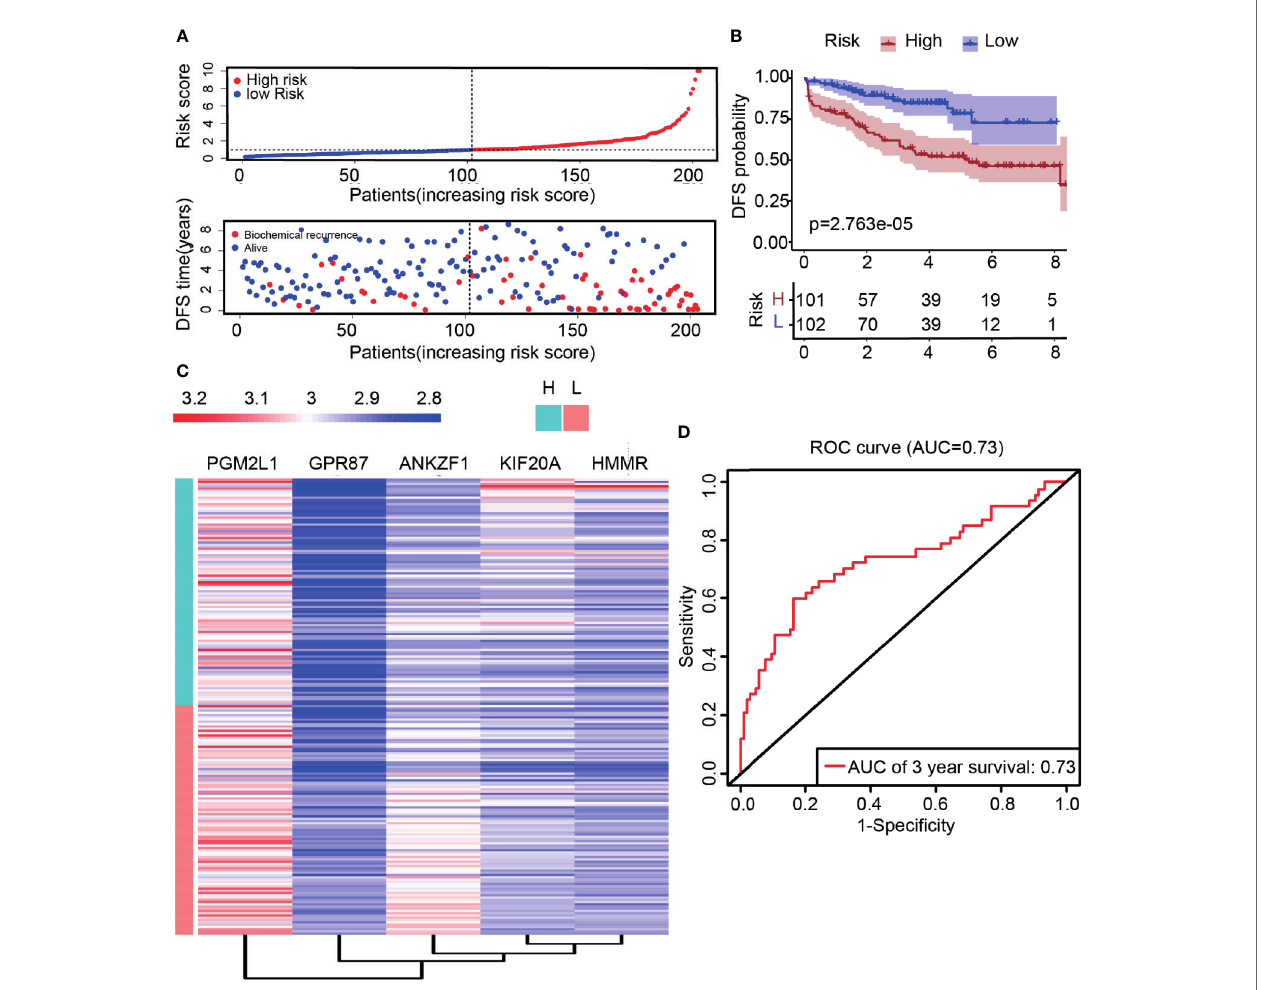
FIGURE 5 | Validation of risk score through external data derived from the GEO dataset (GSE70770). (A) The distribution of the fi ve-mRNA risk score and survival status for each patient. (B) Kaplan – Meier curve of survival time in high- and low-risk groups. (C) Expression of fi ve glycolytic genes in the high-risk group and low- risk group based on GSE70770. (D) ROC curve of DFS (AUC = 0.73) in validation